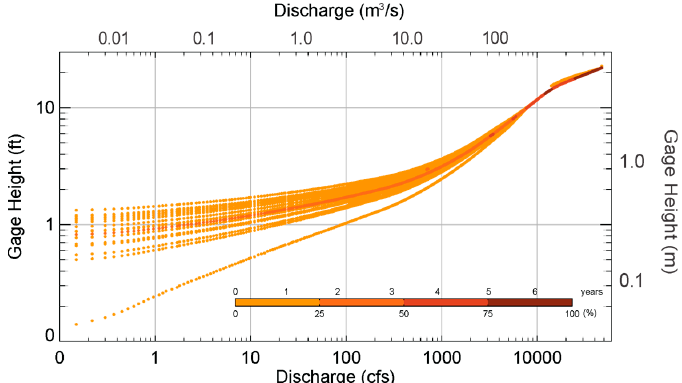
Figure 8. Duration (in years) of individual stage–discharge relationships in Skunk River at Merrimac.